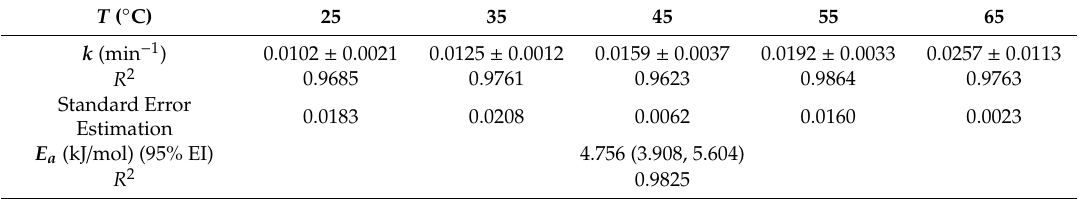
Figure 9. The e ff ects of temperature on the anthocyanin retention ratio of berry puree. Table 4. The degradation rate constants and activation energy of anthocyanin in berry puree at di ff erent temperatures.